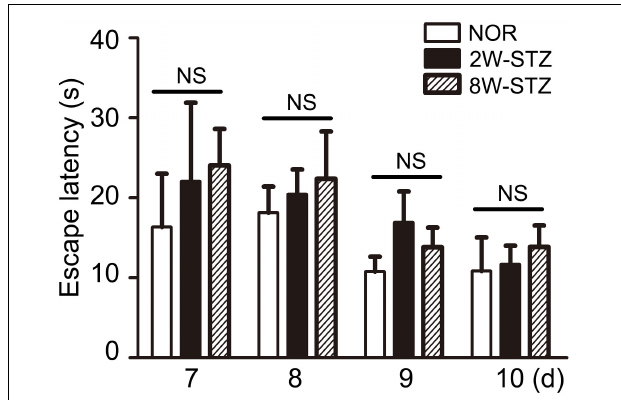
FIGURE 3 | Diabetic rats’ performance in working memory was not worse. Working memory test was conducted from day 7 to day 10 in the cognitive evaluation. Working memory was to conduct a consecutive four-day experiment and two trials a day. We set trial 1 as a sample trial, bar graph showed no statistically significant difference in trial 2 among the diabetic and normal rats. Data are mean ± SEM, n = 6–8 per group. NOR, normal rats;